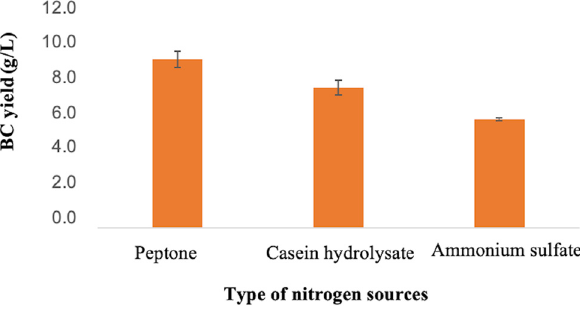
Figure 5: BC yield ( g/L ) produced by P. kudriavzevii USM - YBP2 sup - plemented with di ff erent type nitrogen sources; peptone, casein hydrolysate, and ammonium sulfate at 30°C under static